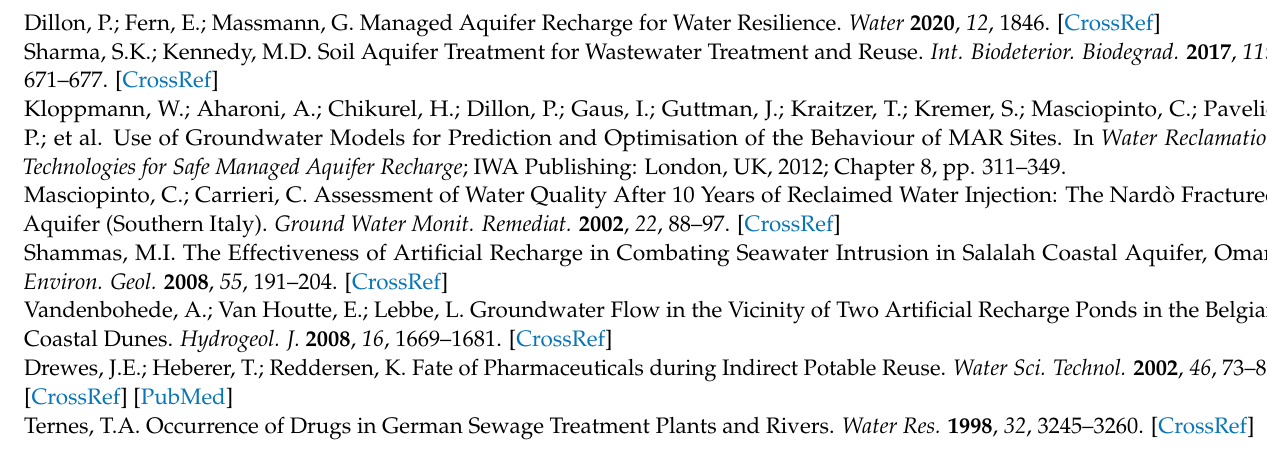
Table S2: Average flow rates and average proportions of STWW in the aquifer from 2017 to 2021 for the baseline model and other models with different parameters for the main flowlines from the different infiltration basins 1, 2, 3 to the Goulot stream (Flowlines 1, 2, 3) and from the Goulot stream to the coastline (Flowline